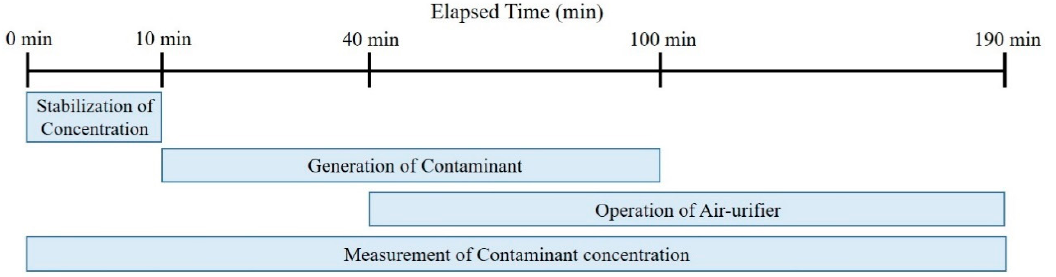
Figure 8. Experiment progress.